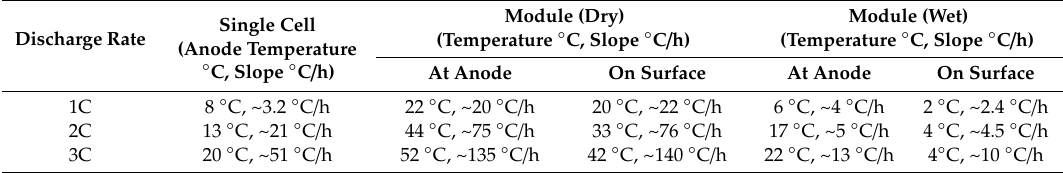
Table 3. The summary of measured temperature increase over the discharge periods and cooling e ffi ciency on the cell module.